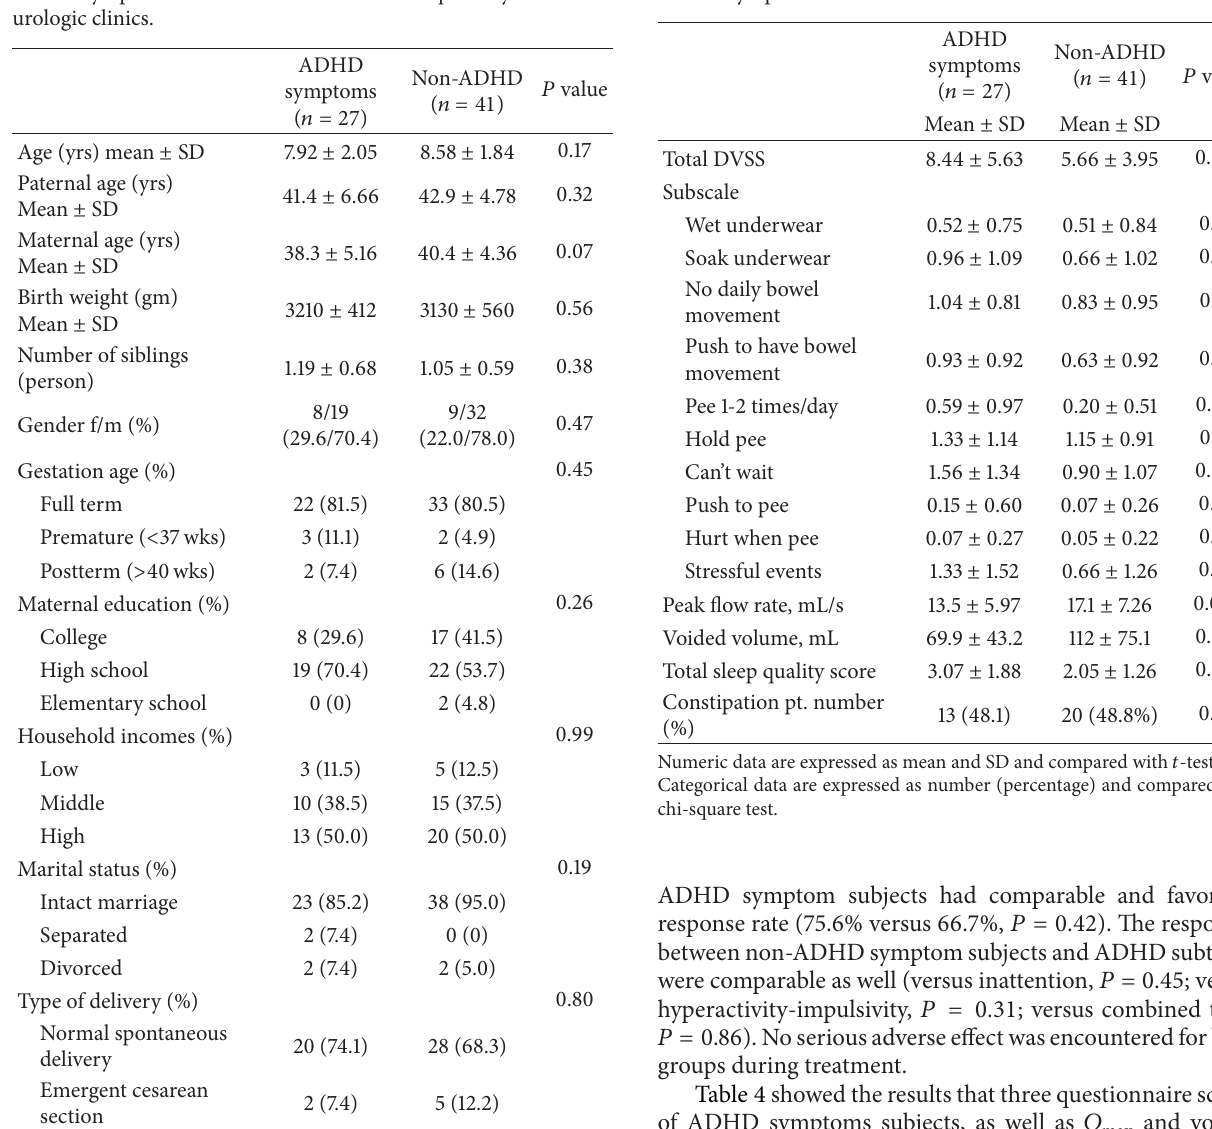
Table 2: LUTS and flow rates in study subjects categorized by ADHD